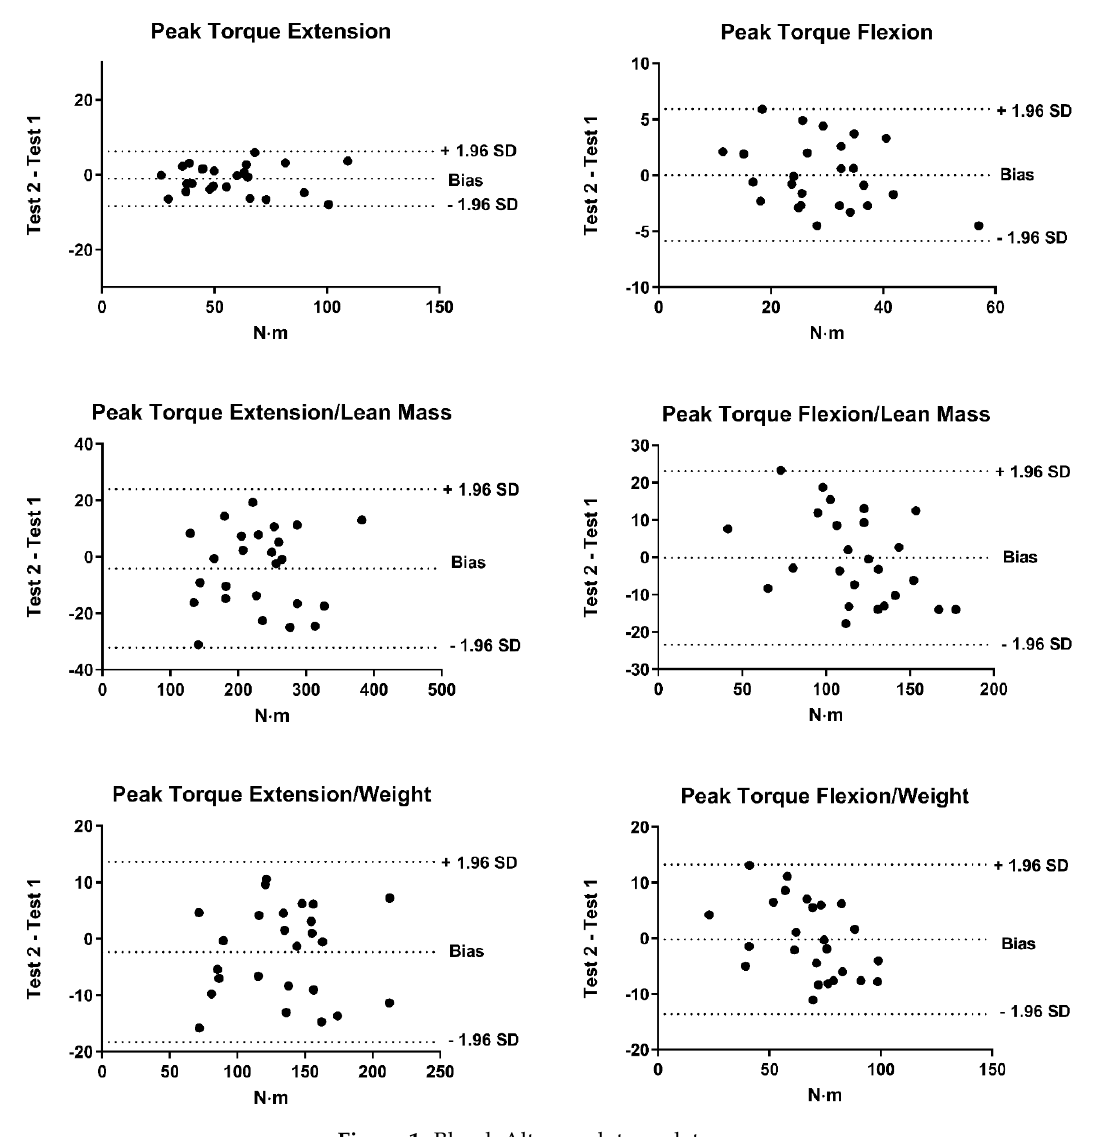
Figure 1. Bland–Altman plots peak torque.